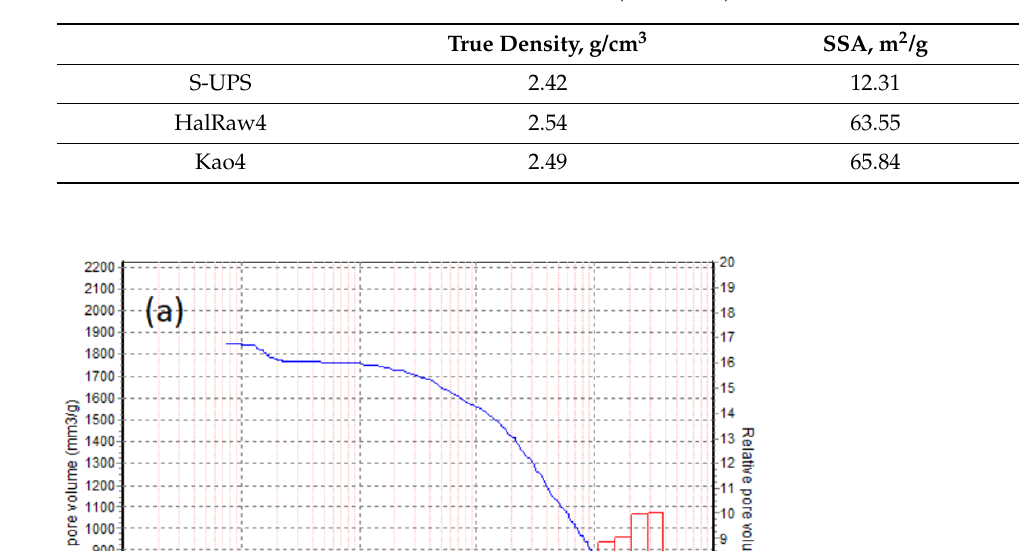
Table 3. True density and specific surface area (SSA) of the obtained adsorbent samples based on straw biomass ash with nano-structural additives: S-UPS; HalRaw4; and Kao4.